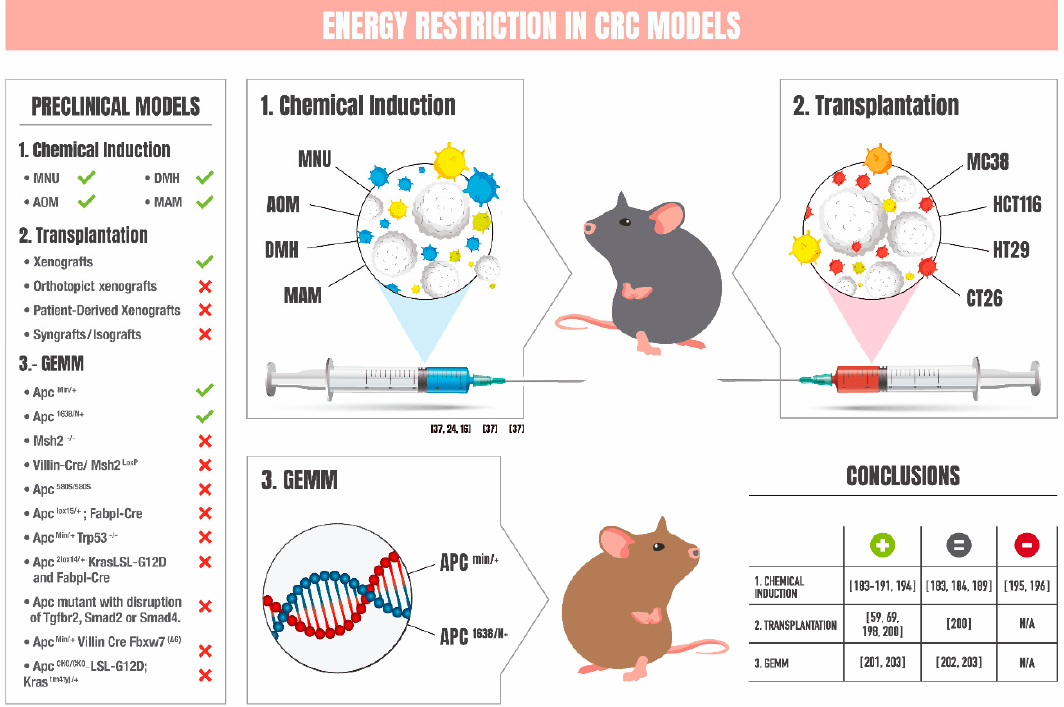
chemically induced models of CRC. Male F344 rats were given 2-AOM injections once a week at the age of 7 weeks. Thereafter, rats were fed to 20% CR on a low-fat diet (LFD), or fed to 10%, 20%, or 30% CR regimen on a HFD for the next 32 weeks. Unexpectedly, 20% CR on LFD did not significantly reduce tumor incidence (i.e., % of animals with tumors) or tumor multiplicity (i.e., number of tumors per animal) when compared to LFD controls fed ad libitum (AL) [190]. In the context of an obesogenic